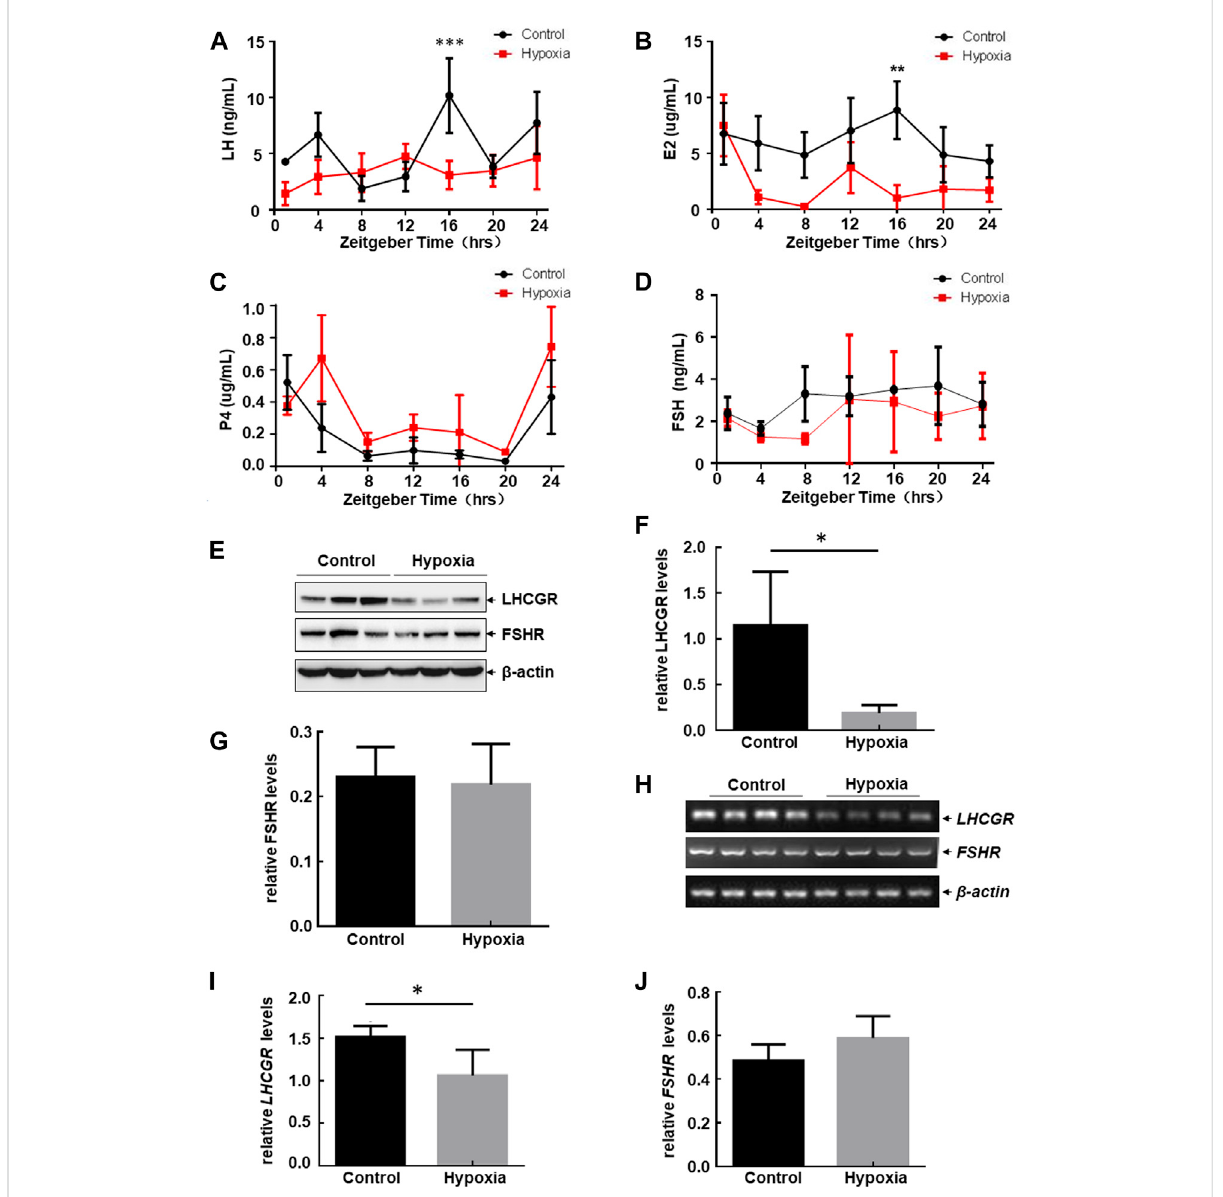
FIGURE 2 Hypobaric hypoxia induced the impairment of LH-LHCGR pathway activation in the ovaries of female mice. (A – D) Female mice were exposed to hypobaric hypoxia. The mice were euthanized every 4 h. Serum levels of sex hormones were analyzed by ELISA ( n = 6, *** p < 0.0001; ** p < 0.01). (E – J) Female mice were raised under normoxic or hypobaric hypoxic conditions at ZT0. Ovaries were collected 48 h after hypoxic exposure and subjectedtoWesternblot(E) orRT-PCRassays (H).The quantitative results of eachtarget protein(relative to β -actin)are shown (F – G,I – J) ( n = 6 – 8, * p <